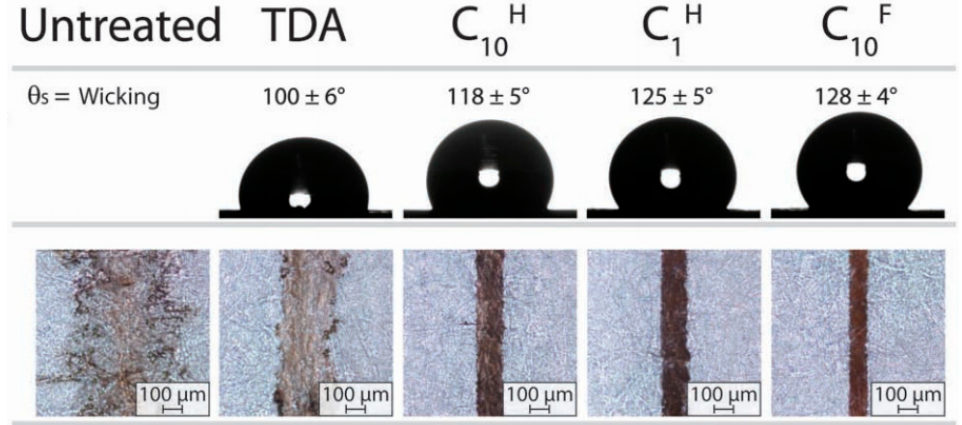
Figure 7. Demonstration of change in ink contact angle and print resolution due to chemical modification of the paper substrate by Lessing et al. Reproduced with permission from [41], Copyright Wiley-VCH, 2017.